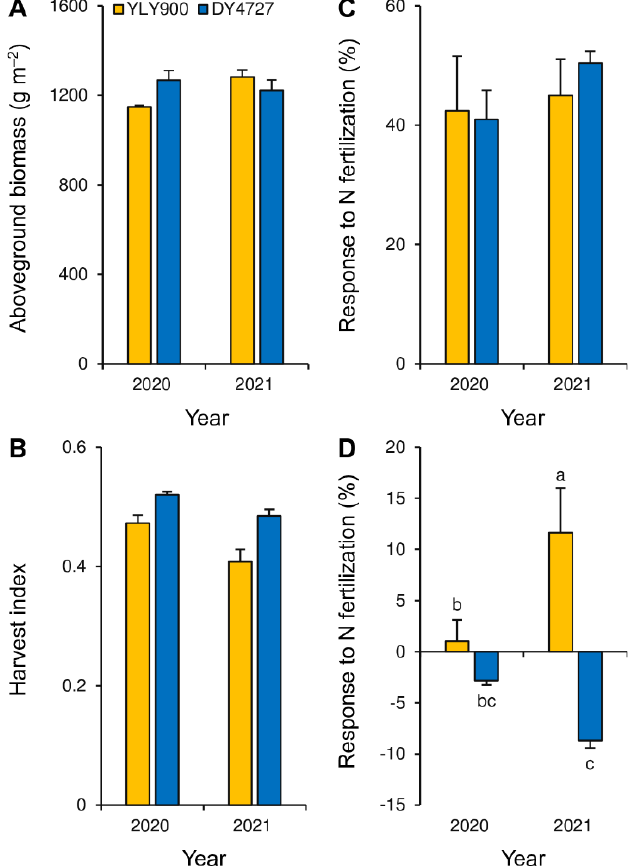
Figure 4. Aboveground biomass ( A ) and harvest index ( B ) under the zero-N fertilization condition and their responses to N fertilization (180 kg N ha − 1 ) relativized to zero-N fertilization ( C , D ) in two hybrid rice varieties, Deyou 4727 (DY4727) and Y-liangyou 900 (YLY900), grown in 2020 and 2021. Data are means (columns) and standard errors (bars) of three replications. In ( D ), means not sharing any letter are significantly different at the 0.05 probability level.